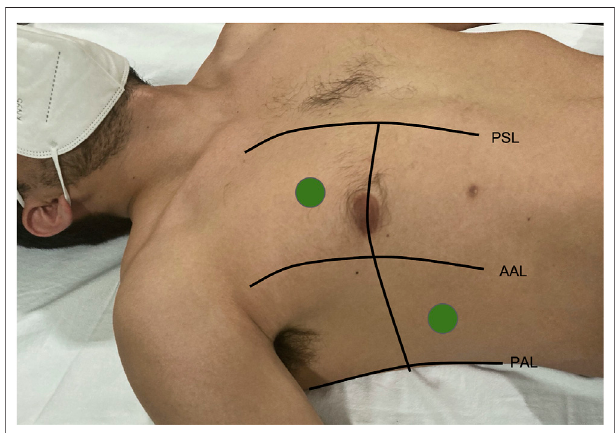
FIGURE 1 | Schematic lung ultrasound